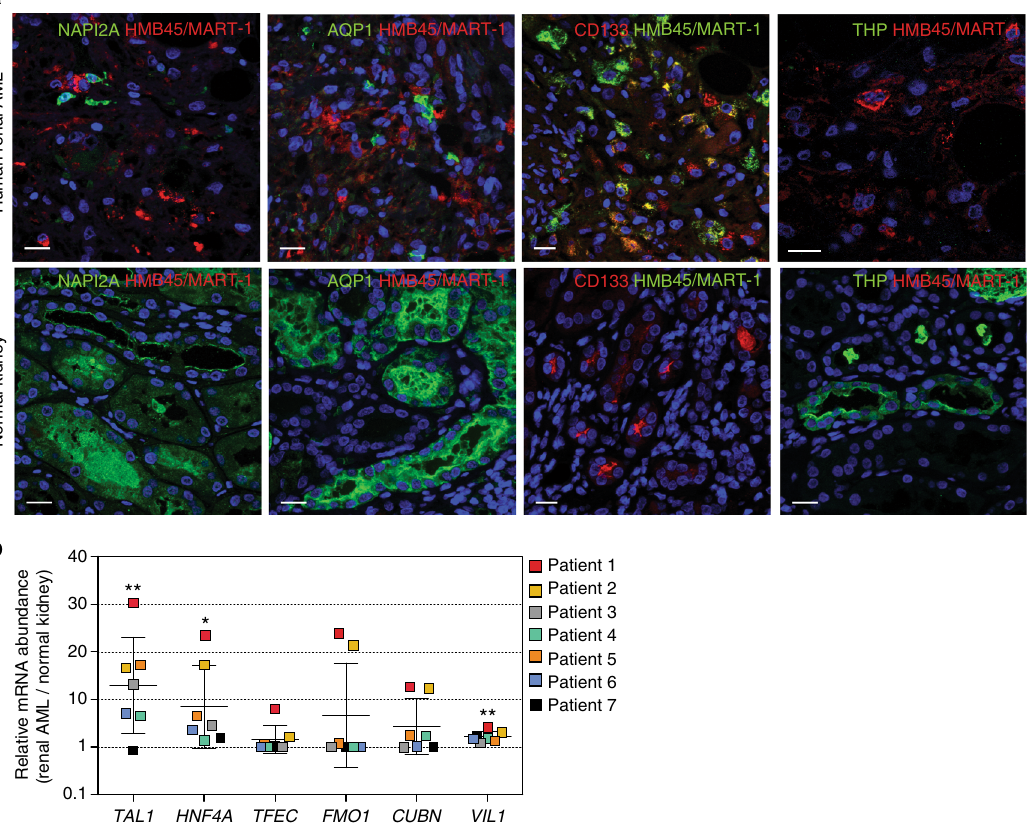
Fig. 6 Human AML tumours express proximal tubule markers. a Representative immuno fl uorescence co-stainings for the melanocytic/AML marker HMB45/MART-1 and the proximal tubule epithelial markers NAPI2A, AQP1 and CD133 and distal tubule epithelial marker Tamm Horsfall glycoprotein (THP) in human renal AMLs (top row) and normal kidney (bottom row). Scale bars: 50 μ m. b Relative mRNA abundance (renal AML vs. matched normal kidney) of three selected transcription factors ( TAL1 , HNF4A and TFEC ) and three proximal tubule markers ( FMO1 , CUBN and VIL1 ) in seven human AML cases. The graph shows the values for each patient and the whisker plot depicts mean ± s.d. * denotes P < 0.05 and ** P < 0.01 (Student ’ s t test) statistically signi fi cant different expression between AML and